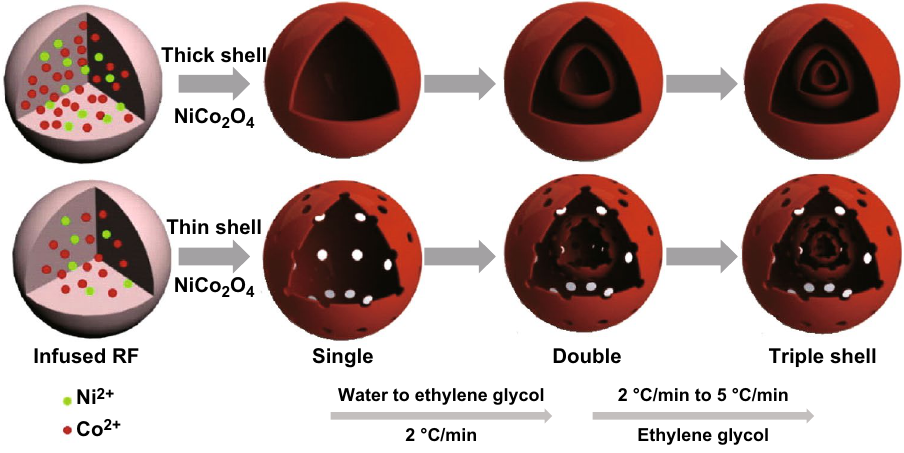
Fig. 12 Pictorial representation for the formation of NiCo 2 O 4 hollow microspheres with tunable numbers and shell thickness. Reproduced with permission from Ref. [131]. Copyright © 2016 Elsevier